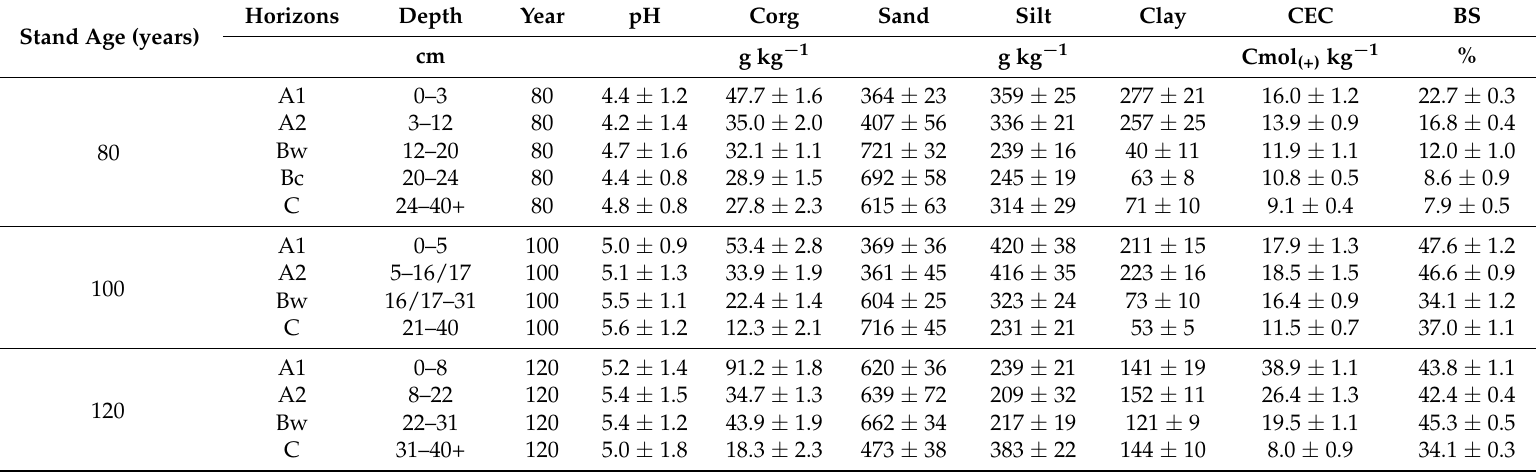
Table 2. Main physico-chemical properties of investigated pedons. Values are mean ± standard error ( n = 3). Stand Age